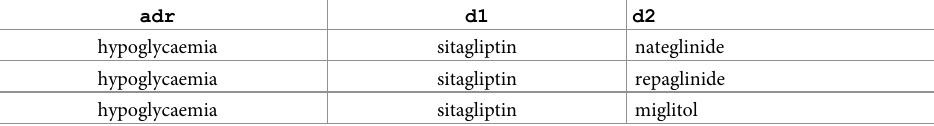
Table 5. Example of a dataset for analyzing the ADR ( adr ) for the concomitant use of two drugs ( d1 and d2 ) for the listds